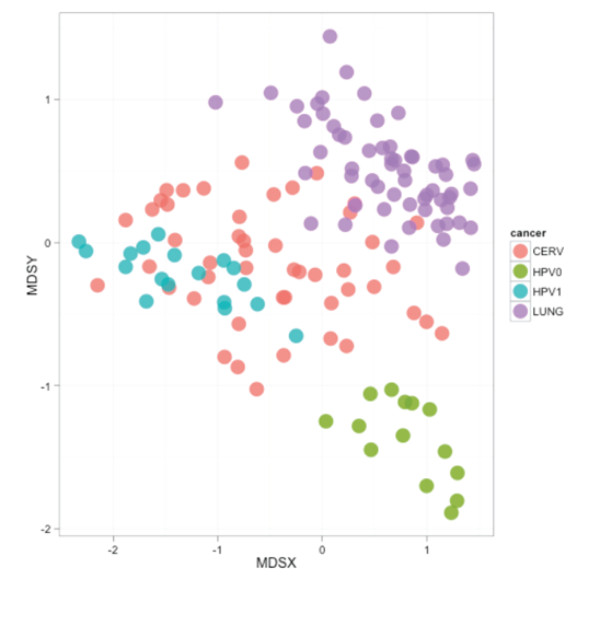
Multidimensional scaling using the four datasets. These datasets were comprised of 48 cervical-cancer samples (CERV; pink), 59 lung-cancer samples (LUNG; purple), 18 human papillomavirus-positive (HPV+) head and neck squamous cell cancer (HNSCC) samples (HPV1; light-blue) and 14 HPV-negative (HPV-) HNSCC samples (HPV0; green), using a selection of HPV-associated versus smoking-associated features identified by comparing HPV+ versus HPV- HNSCC.